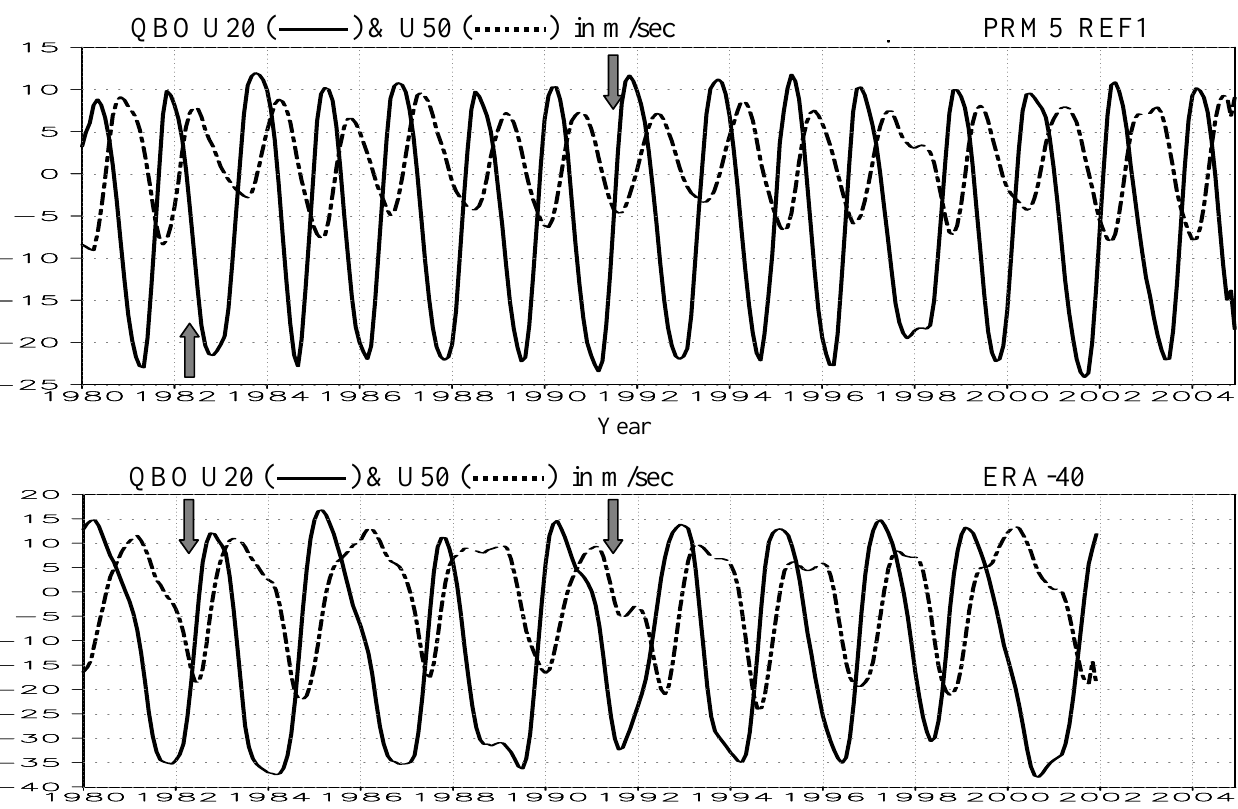
Fig. 8. Evolution of the zonal-mean zonal winds (m/s) at 20hPa (solid curve) and 50hPa (dashed curve) over the equator for the simulation (upper) and observation (ERA-40) (lower). Arrows represent the eruption dates of El Chich´on and Mount Pinatubo.